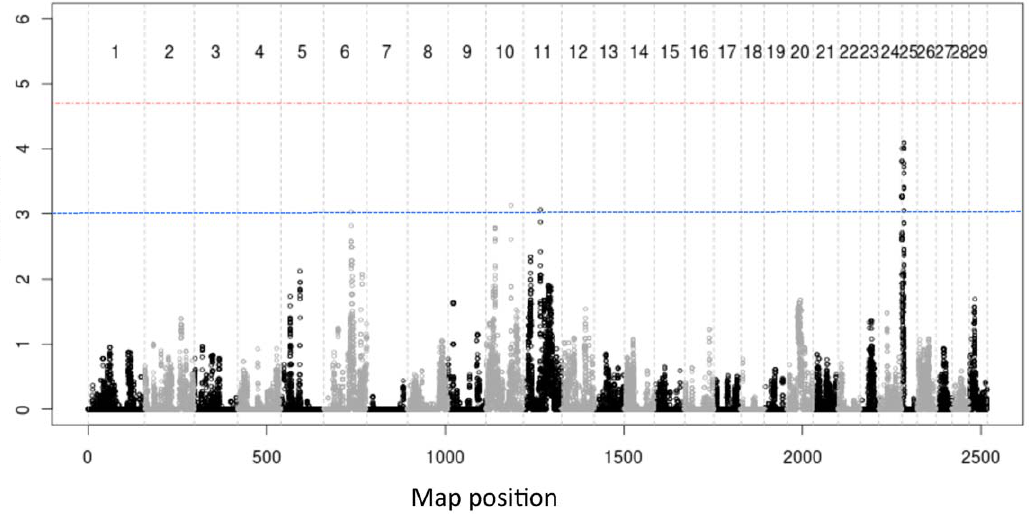
Figure 5. Results of genome-scan for QTL affecting the normalized distance between pairs of CO events measured in base-pairs (GIL bp ), using a method that simultaneously extracts linkage and LD signal [ 34 ] . The red and blue horizontal lines mark the genome-wide significant and suggestive thresholds determined by permutation testing.